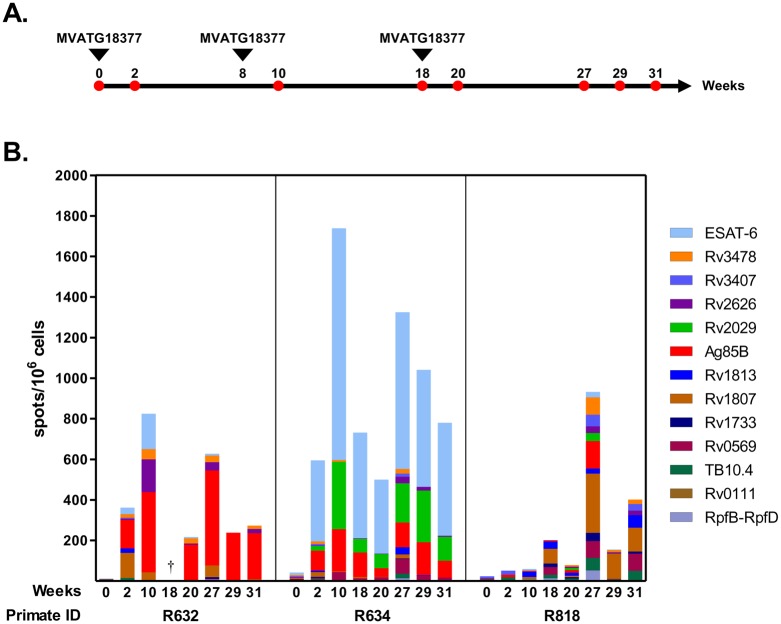
ELISpot analysis of IFNγ responses specific of MVATG18377-encoded Mtb antigens in non-human primates.(A) Overview of primate experimental design. Three primates were immunized thrice with MVATG18377 at Weeks 0, 8 and 18 (arrowhead). IFNγ ELISpot assays were performed with PBMCs collected at indicated time points (red point). (B) Antigen-specific IFNγ responses. Results are shown as the number of IFNγ-producing cells (spots) per 106 cells following stimulation with peptide pools specific of each of the 14 antigens. At each time point, cumulative results following stimulation with each of 14 antigens are represented. A color code is used for each antigen. †, data are not available due to cell culture issues.